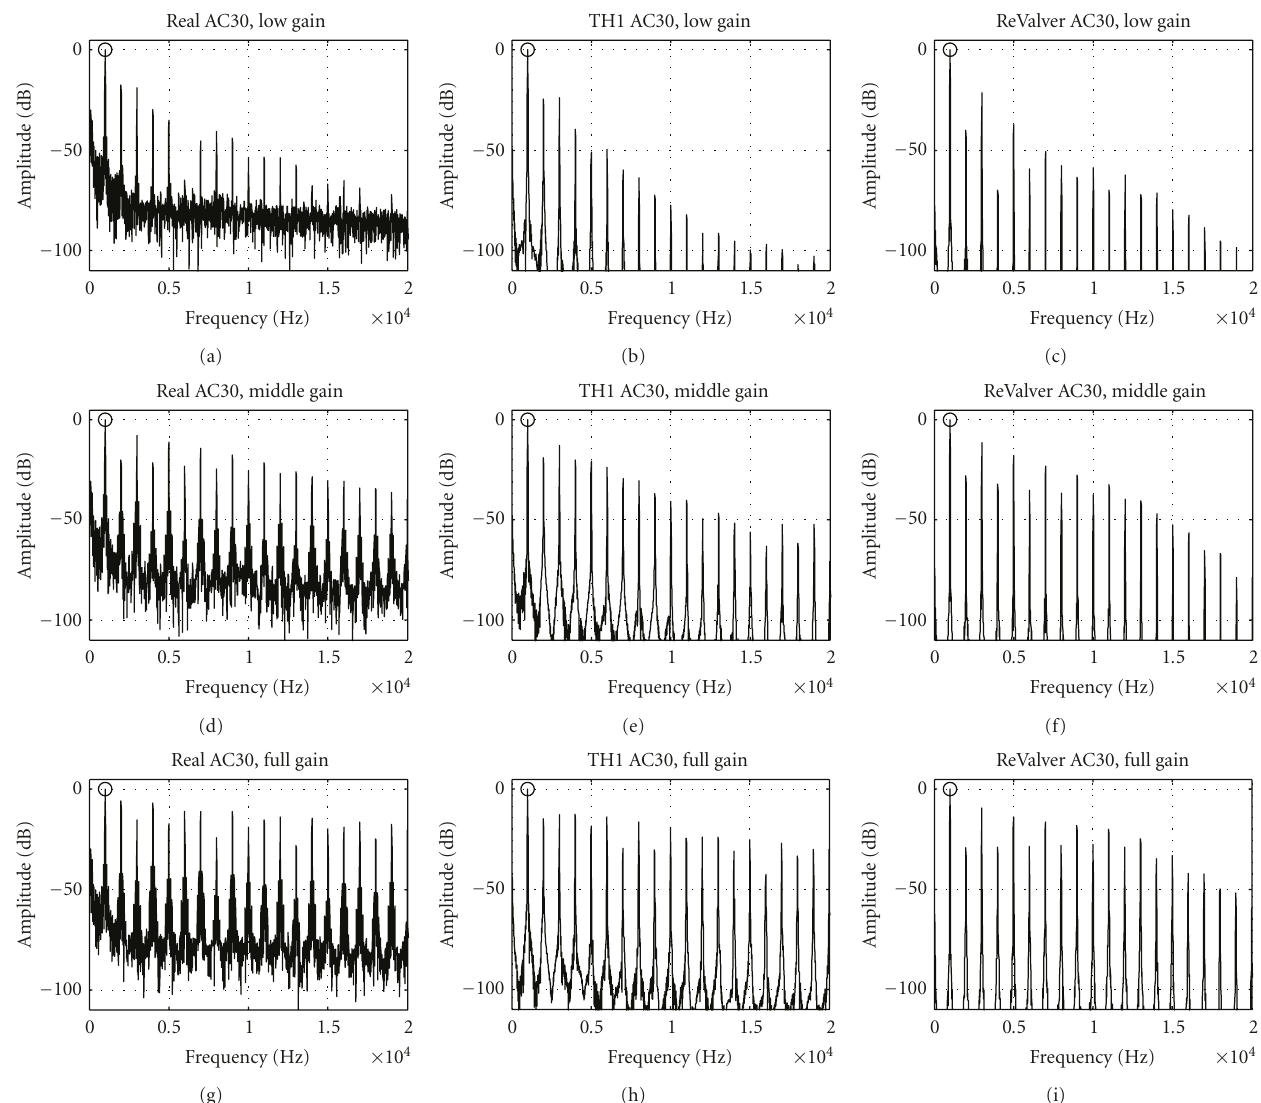
Figure 5: Response spectra to a 1kHz sinusoid for the real AC30 (left column), the Top30 unit of the TH1 software plugin (middle column), and the FOX ACS-45 unit of the ReValver software plugin (right column). The user adjustable gain knob was first set to 9 o’clock (top row), then to 12 o’clock (middle row), and finally to full (bottom row). As expected, the real AC30 has a higher noise floor than the digital versions.